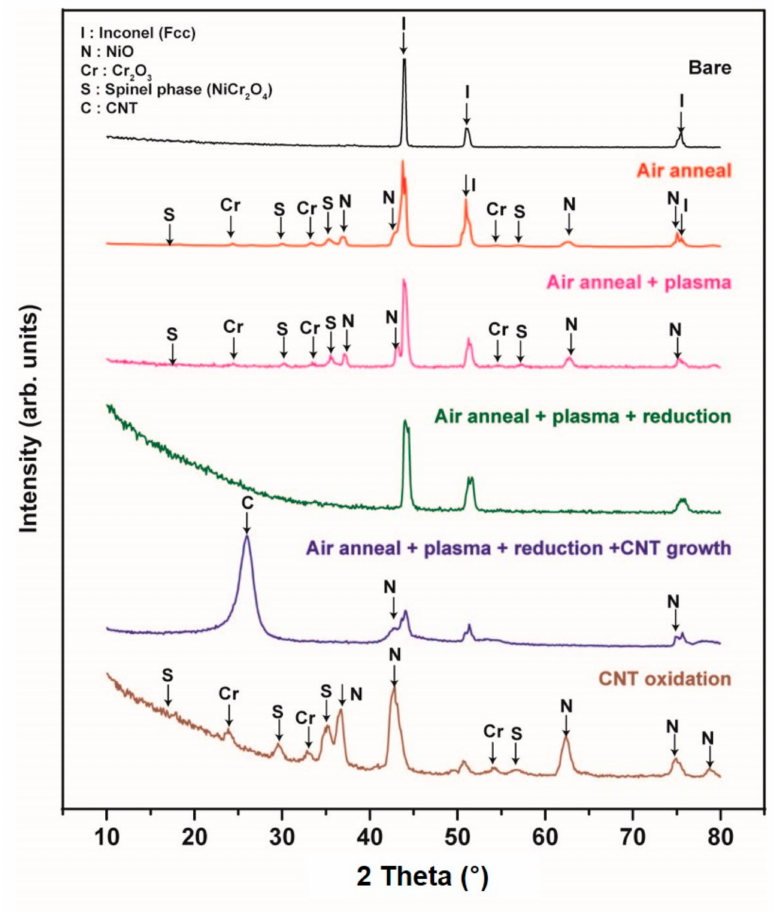
Figure 4. XRD profiles recorded at each step: as-purchased, air annealing, plasma treatment, reduction before growth, CNT growth and CNT oxidation after